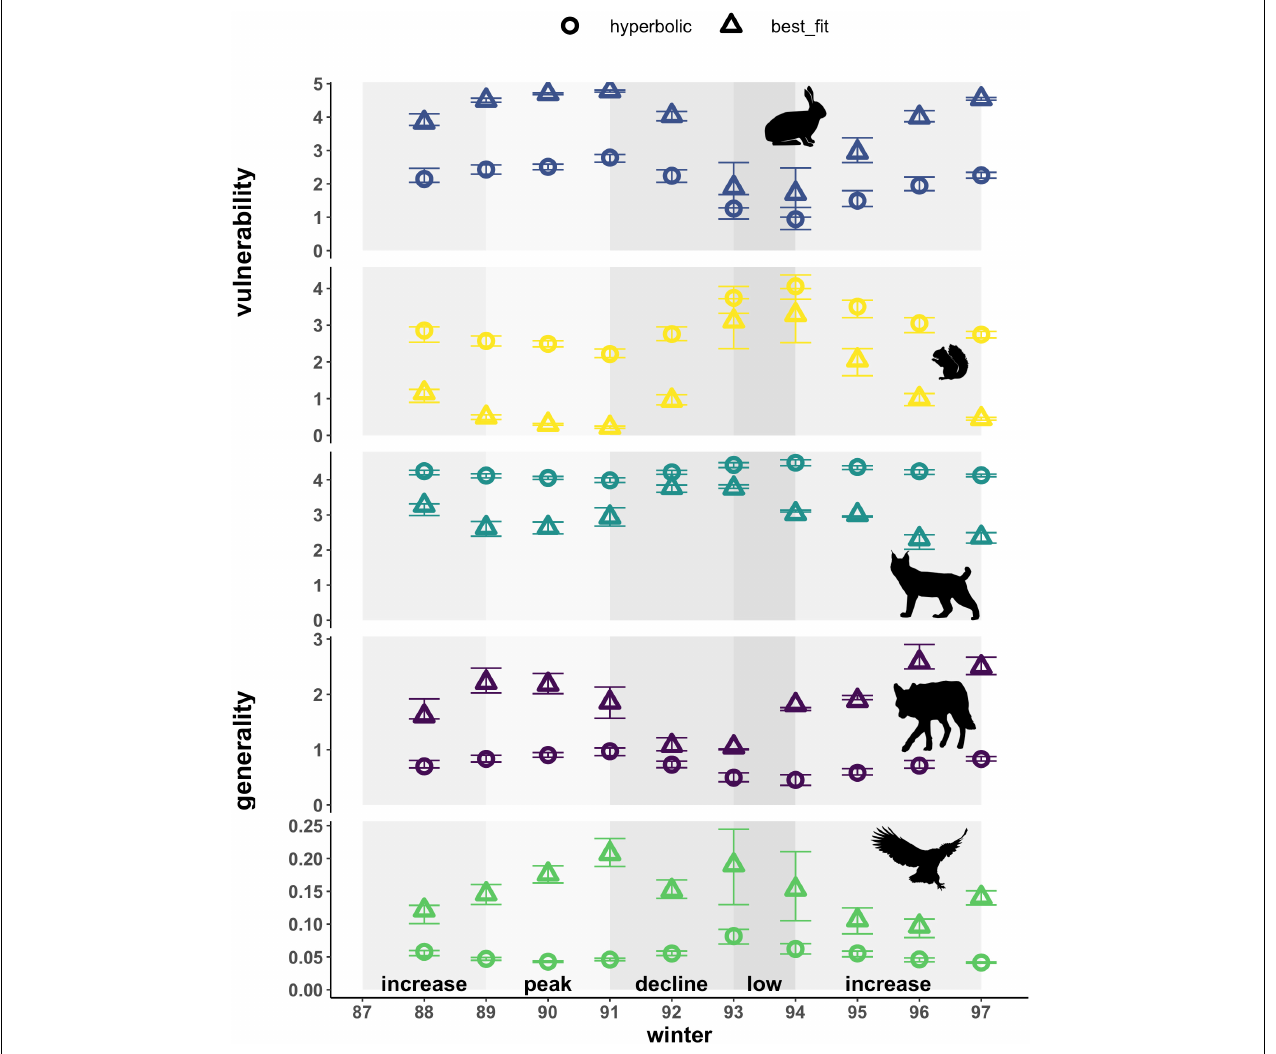
FIGURE 6 | Weighted node-level vulnerability of prey and generality of predators based on hyperbolic and best-fit functional response models. Vulnerability represents effective numbers of predator species that kill each prey, weighted by per capita kill rates on that prey. Generality represents effective numbers of prey species killed by a predator, weighted by the per capita kill rates of that predator. Effective numbers of prey/predators are standardized to yield equivalent numbers of prey/predators per node. Error bars show uncertainty in vulnerability and generality based on upper and lower limits of 95% confidence intervals for hare density estimates. Shading indicates phases of the cycle as defined by hare density. Also note varying y-axis scale for each